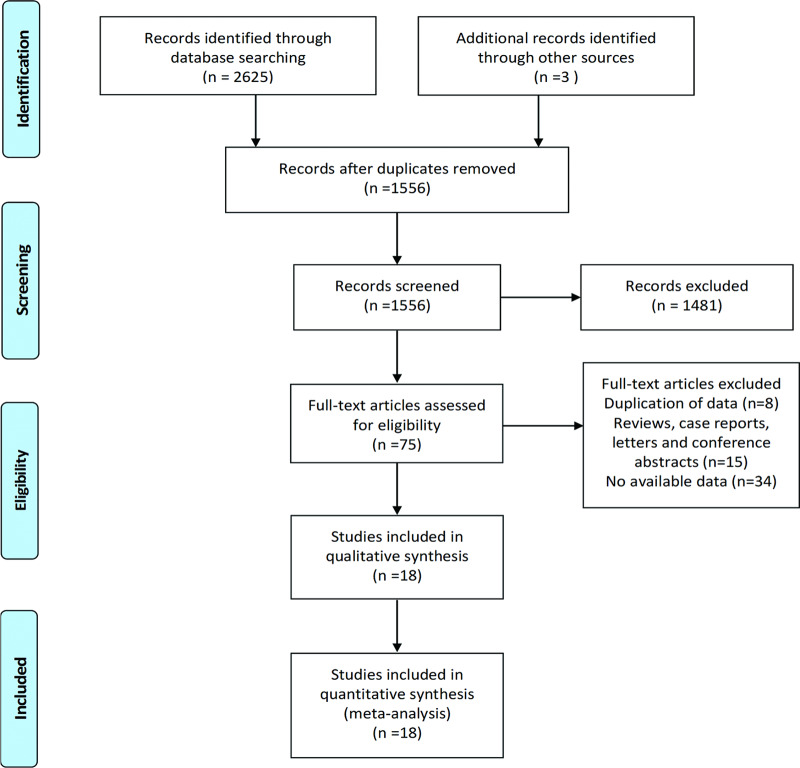
PRISMA flow diagram of studies selection.